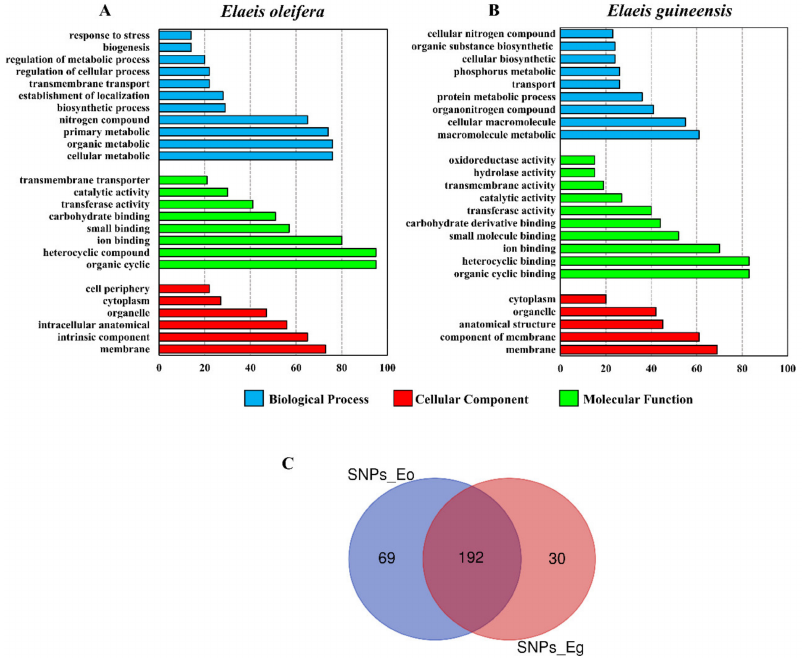
Figure 4. Functional annotation of genes containing SNPs in E. oleifera ( A ) and E. guineensis ( B ). Venn diagram comparing genes containing intragenic SNPs in E. oleifera and E. guineensis ( C ). Functional annotation was performed on the OmicsBox